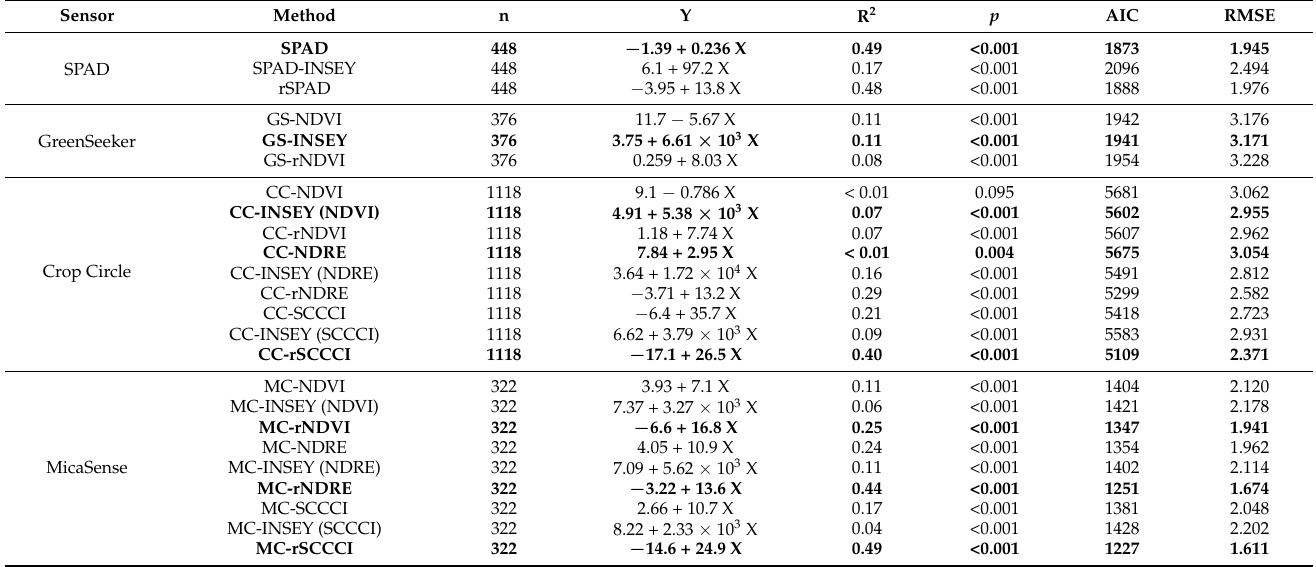
Figure 1. Grain yield vs. relative VI comparison when collected using Crop Circle and MicaSense sensors. Crop Circle relative VIs included NDVI ( A ), NDRE ( C ), and SCCCI ( E ), whereas MicaSense relative VIs included NDVI ( B ), NDRE ( D ), and SCCCI ( F ). The number of datapoints for each equation is represented by n, the equation is represented by y, the coefficient of determination is represented by R 2 , the p -value by P, and the Akaike Information Criterion by AIC. Table 5. Comparison in yield prediction between the raw or % reflectance corrected VI, INSEY, and relative VI values for the SPAD, GreenSeeker, Crop Circle, and MicaSense sensors. The best fit method based on R 2 , AIC, and RMSE for each VI by sensor is bolded. Sensor